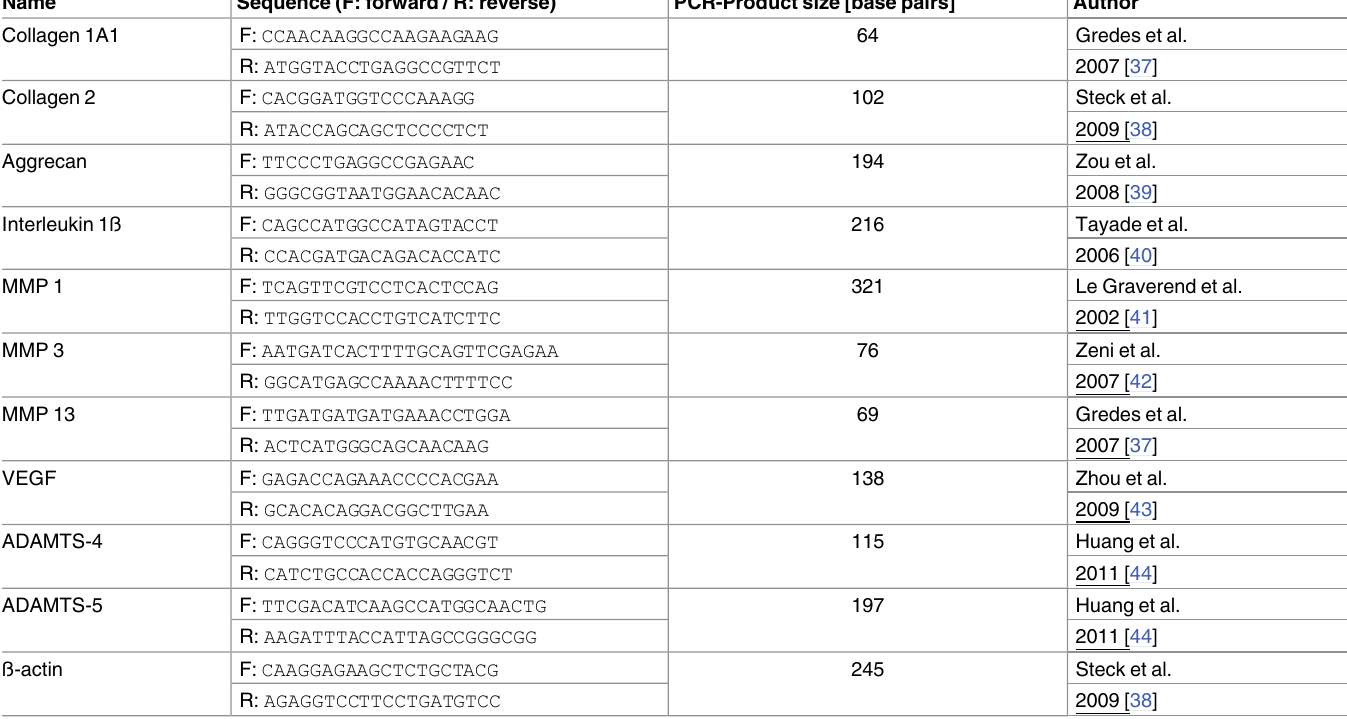
Table 1. Sequences of the used primers and their